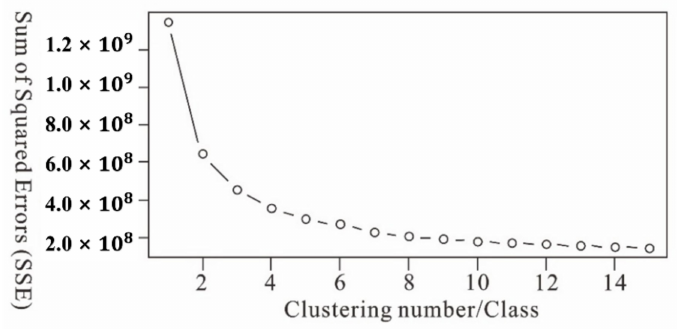
Figure 4. The relationship between Clustering number and the